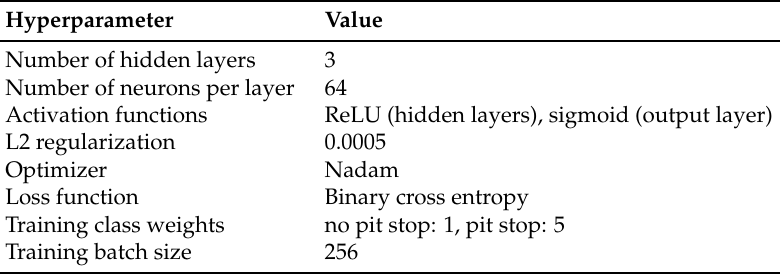
Table 9. Hyperparameters of the neural network for the pit stop decision.